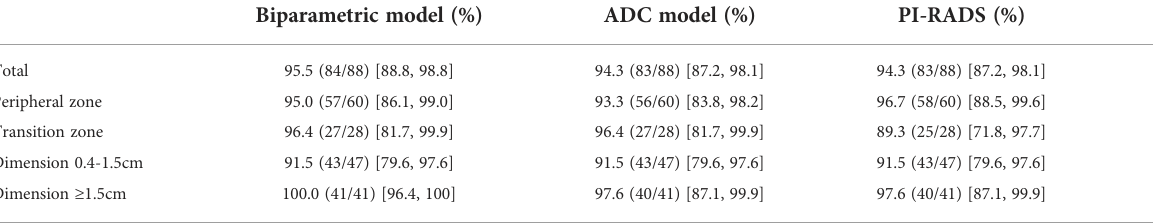
TABLE 3 Per-lesion sensitivity of the models and PI-RADS